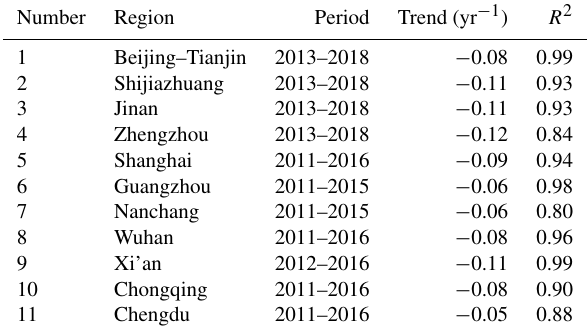
Table 2. NO 2 TVCD trends determined for the period indicated in the third column. Trends are determined using exponential fits ( y = a × e bt ) to time series of the annual mean NO 2 TVCDs as shown in Fig. 3 and described in the